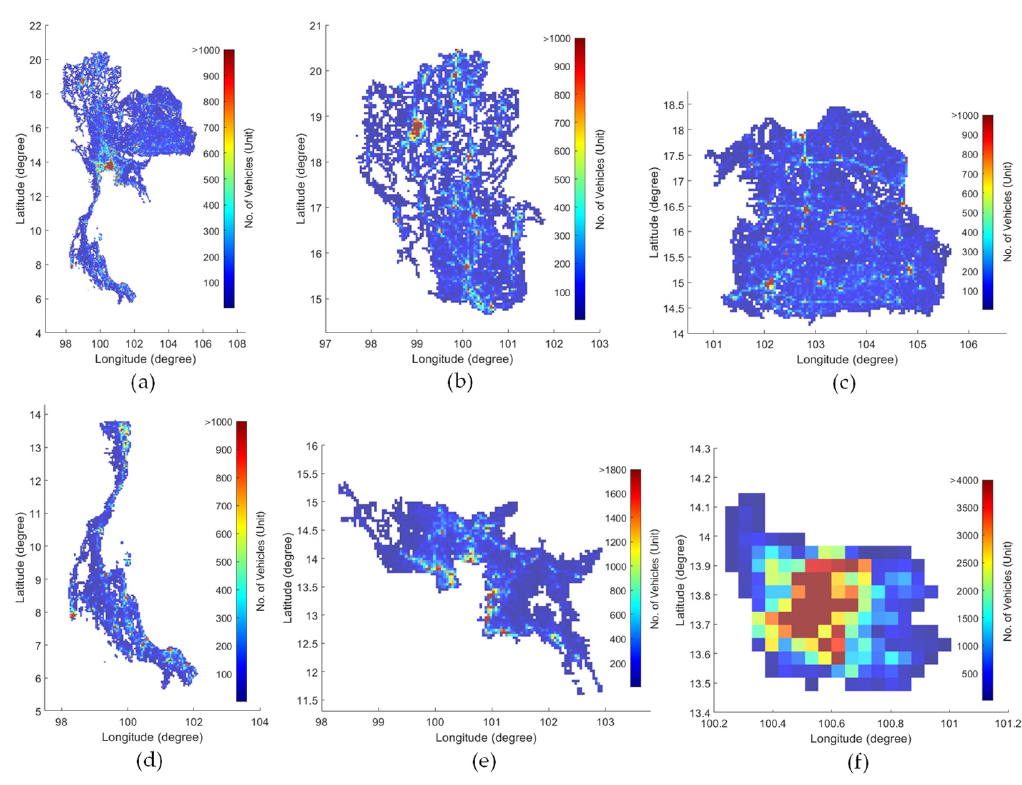
Figure 9. Heat maps representing the number of electric motorcycles in ( a ) Thailand, ( b ) Northern PEA, ( c ) Northeastern PEA, ( d ) Southern PEA, ( e ) Central PEA, and ( f ) MEA.